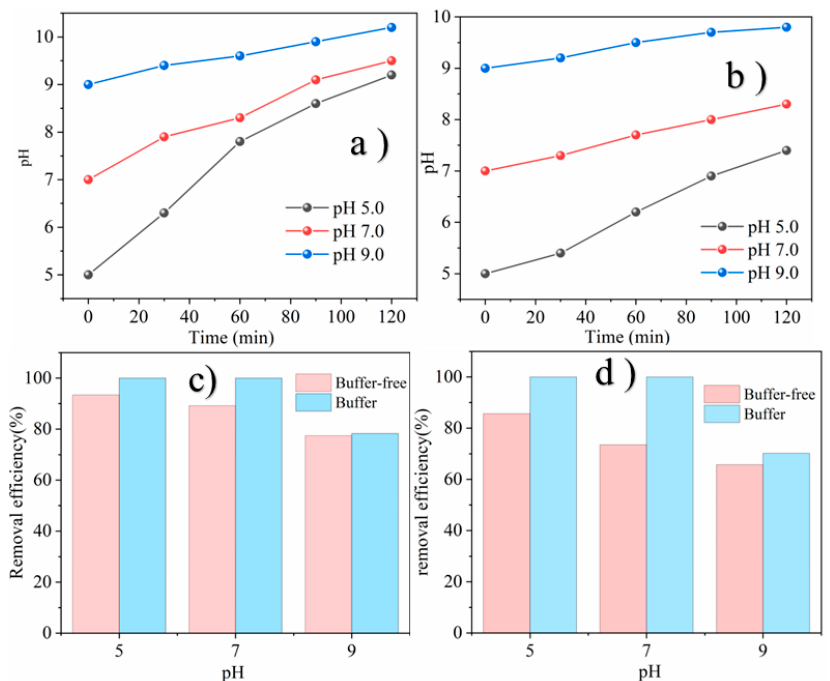
Figure 8. Chemically synthesized FeS and BS-FeS 1+x removed Cr(VI) with or without pH buffer. ( a , b ): pH change without buffer, ( c , d ): Cr(VI) removal comparison with or without buffer. Reaction conditions: FeS 1+x dosage concentration was 1.14 mM; Cr(VI) dosage concentration was 1.14 mM; reaction time was 2 h; and the speed was 200 rpm. BS-FeS 1+x : biosynthesis of iron sulfides containing SRB. Data were plotted as means of duplicates, and the error bars indicate the standard deviation.